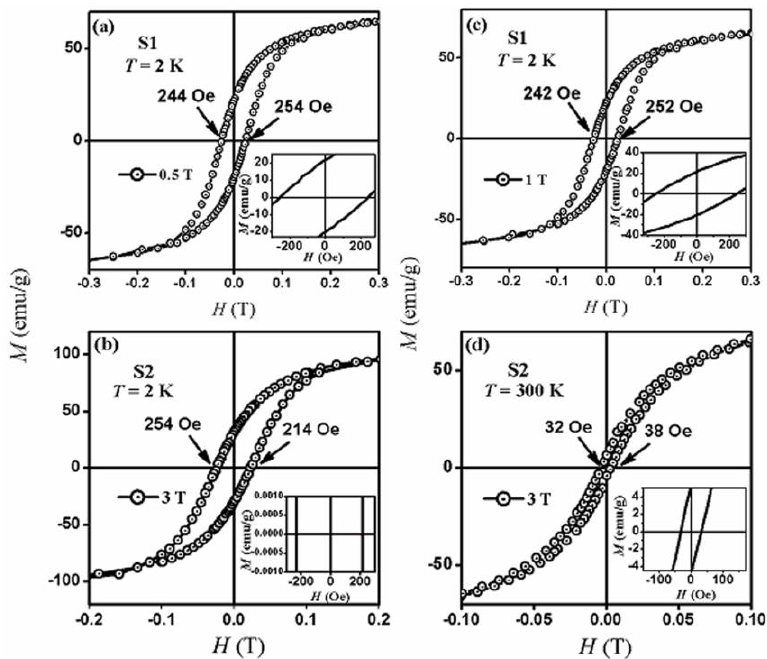
Figure 6. Magnetization versus applied magnetic field ( M - H ) hysteresis loops for ( a ) sample S1 at 2 K and at H FC = 0.5 T; ( b ) sample S2 at 2 K and at H FC = 3 T; ( c ) sample S1 at 2 K and at H FC = 1 T; and ( d ) sample S2 at 300 K and at H FC = 3 T. The insets are enlargements of the region around the origin. From the insets of Figure 6, it was observed that both samples display horizontal loop shifting. The horizontal shift of the loops was defined as the exchange bias field, H EB . From these